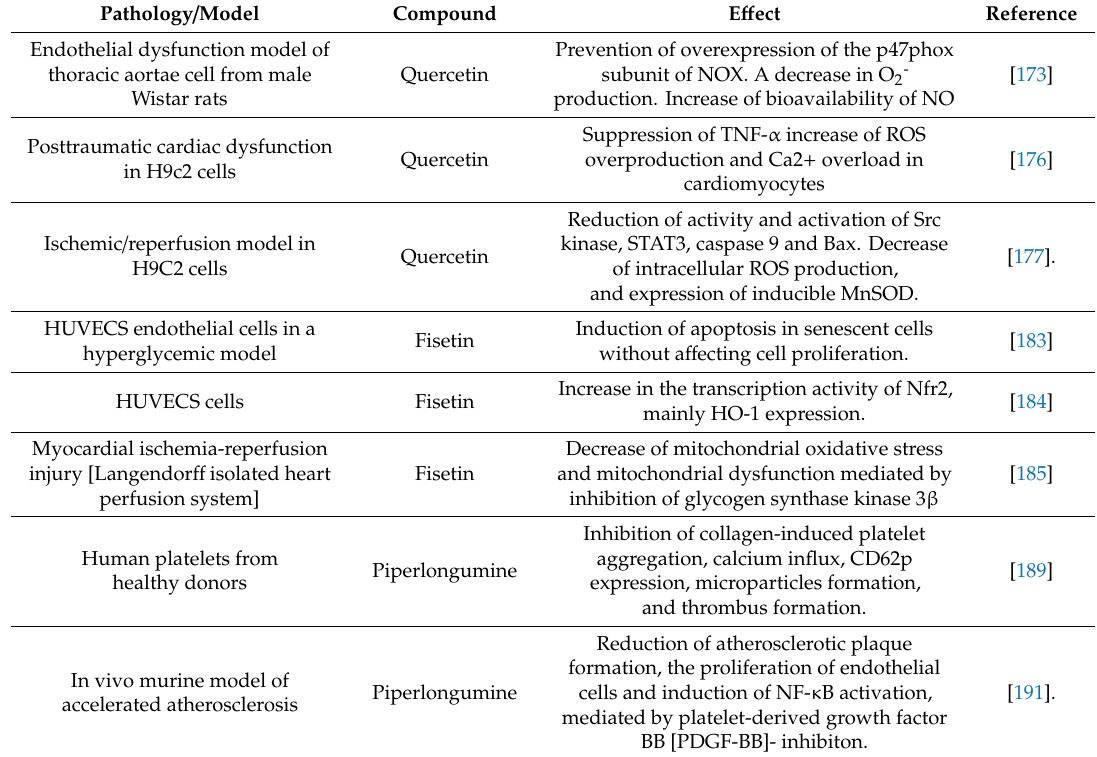
Table 4. The most common and studied senolytic agents that provide mitochondrial